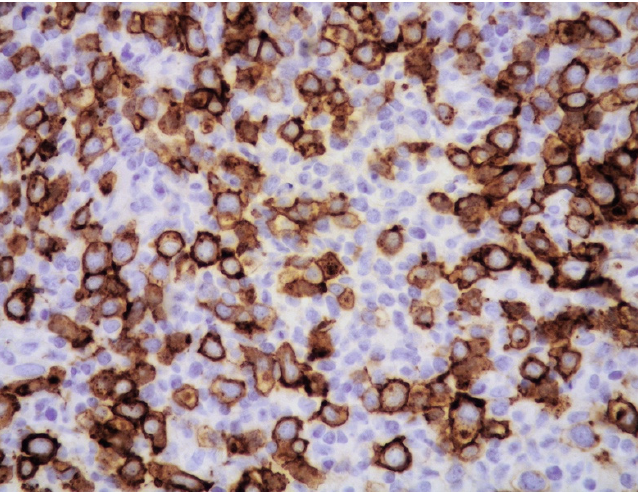
Figure 8. High-power view showing CD30-positive atypical cells (CD30 immunostaining, 400× mag- nification, previously unpublished, original image from S.A.).